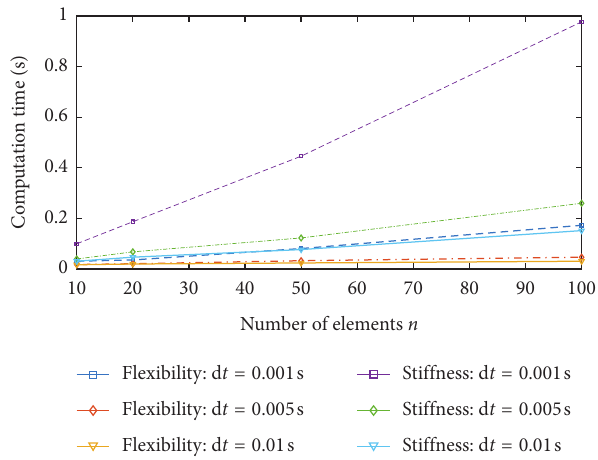
Figure 9: Efficiency comparison between the flexibility method and the stiffness method.